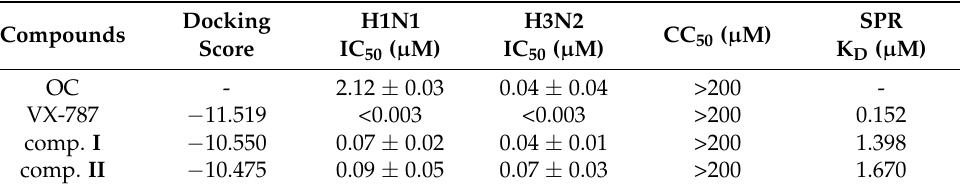
Table 1. Structures, docking scores, anti-H1N1 and -H3N2 activities, cytotoxicities, and K D values of the active